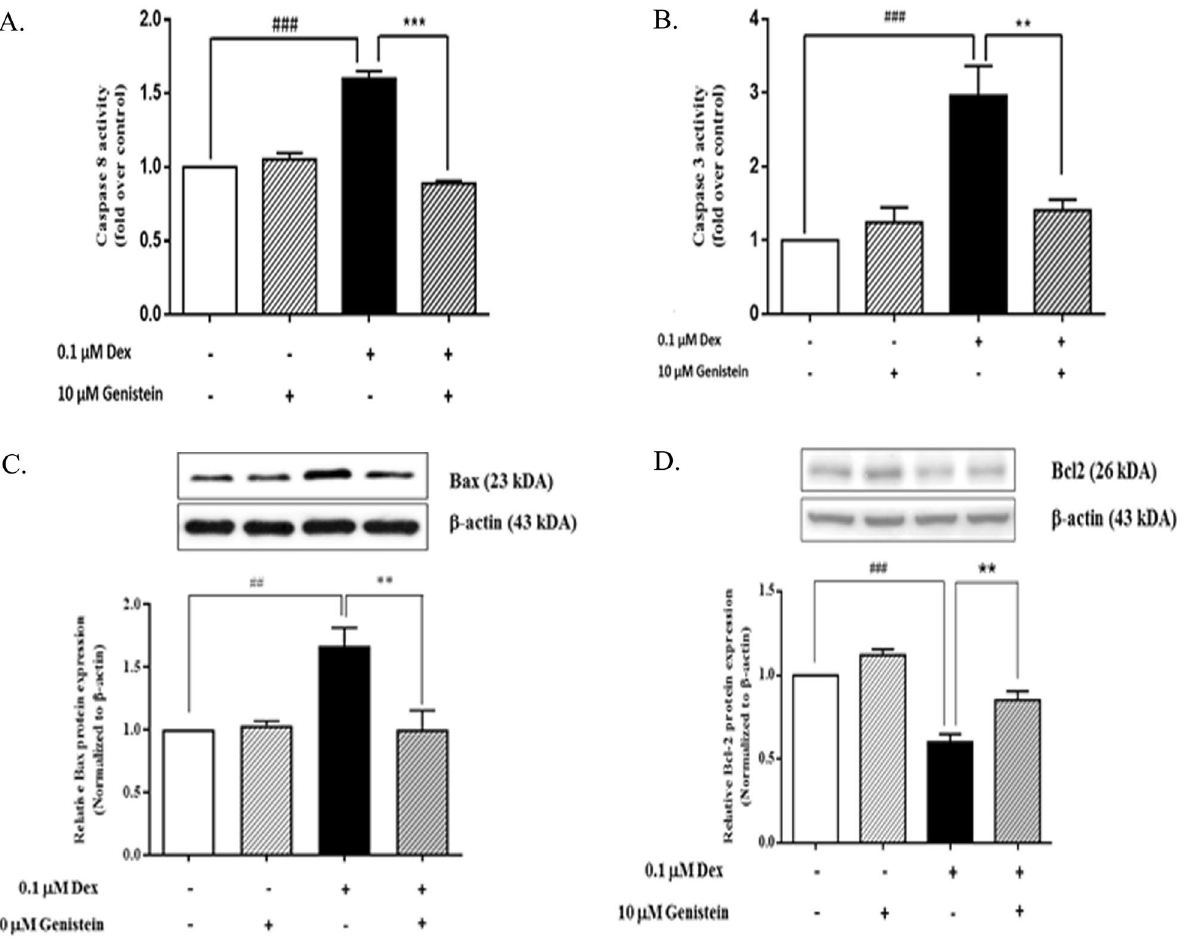
Figure 4. Effect of genistein on dexamethasone-induced dexamethasone on cleaved caspase-3, caspase-8 activity, Bax and Bcl2 in INS-1 cell line. INS-1 cells were treated with 0.1 μM dexamethasone with or without 10 μM genistein. ( A ) Relative level of caspase-8 activity at 48 h. ( B ) Relative level of caspase-3 activity at 48 h. ( C ) A representative Western blot analysis of the pro-apoptotic protein, Bax, normalized to β-actin protein in INS-1 cells at 48 h. All bands were cropped and full-length blots are shown in supplementary Fig. 8. ( D ) A representative Western blot analysis of the anti-apoptotic protein, Bcl-2, normalized to β-actin protein in INS-1 cells at 48 h. All bands were cropped and full-length blots are shown in supplementary Fig. 9. Data are expressed as mean ± SEM of 3–4 independent experiments. ###, P < 0.001 versus control; ##, P < 0.01 versus control; ***, P < 0.001 versus 0.1 µM dexamethasone; ** , P < 0.001 versus 0.1 µM